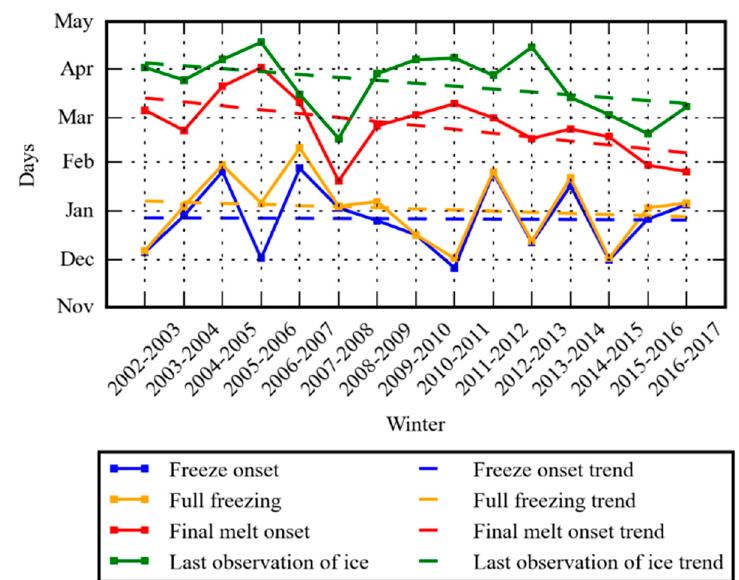
Figure 14. The interannual variability of the ice freeze onset, full freezing, final melt onset, and last observation of ice dates determined from the satellite data (solid lines) and their trends (dashed lines).